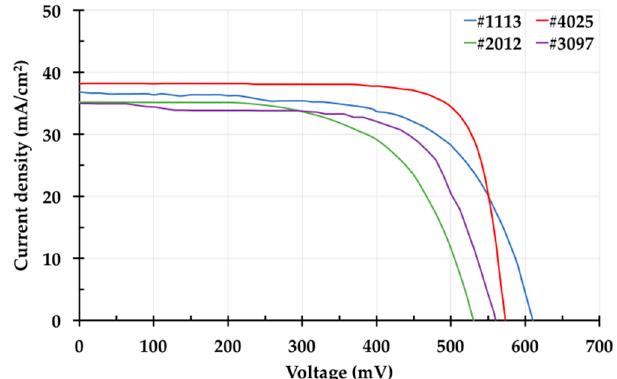
Figure A1. Comparison between the J-V characteristics of four different solar cells all grown on a SLG substrate, except for the CIGS film. #1113 : grown on a ceramic substrate; #2012 : first method—(In 2 Se 3 –Ga 2 Se 3 –Cu); #3097 : second method—(InSe–GaSe–Cu); #4025 : third method—(InSe–